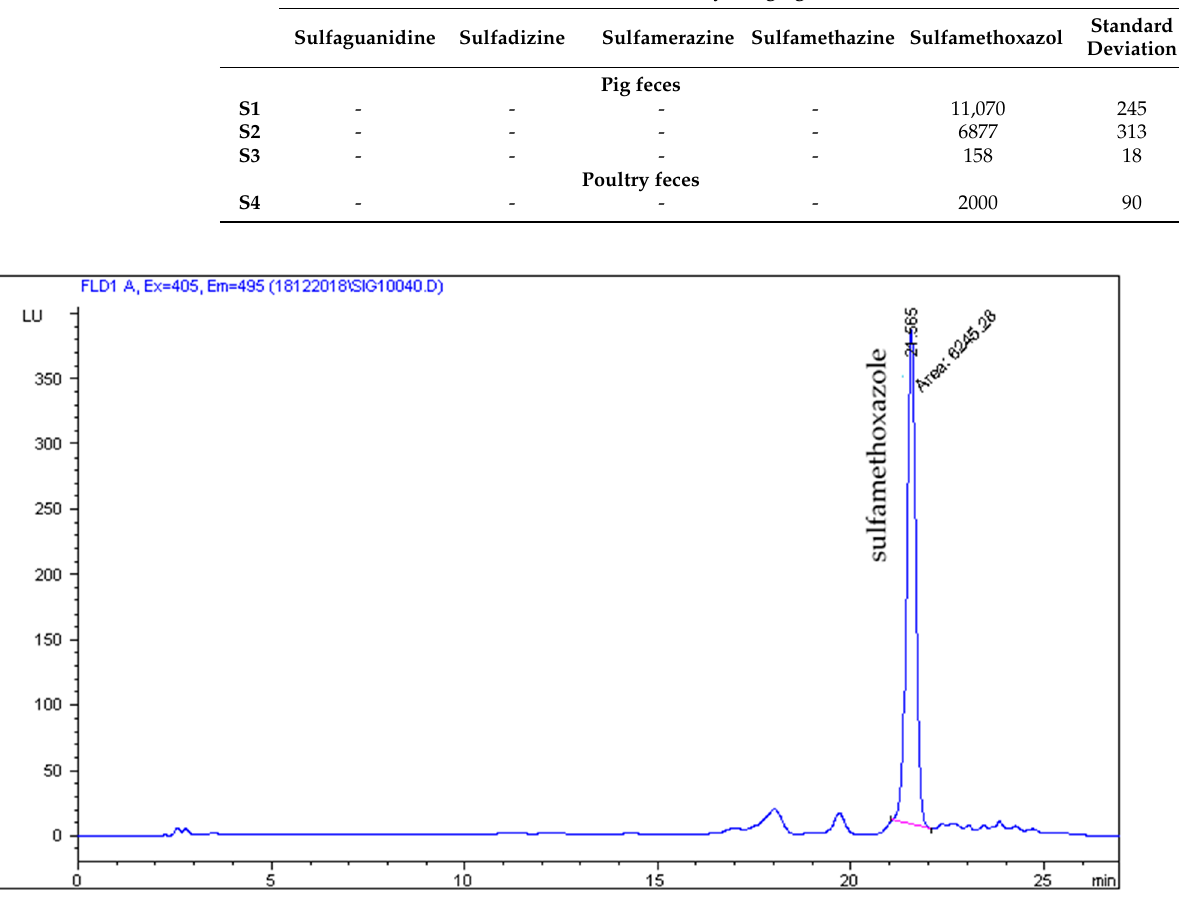
Figure 5. Real sample of solid manure (poultry droppings) with sulfamethoxazole—2000 µg/kg.